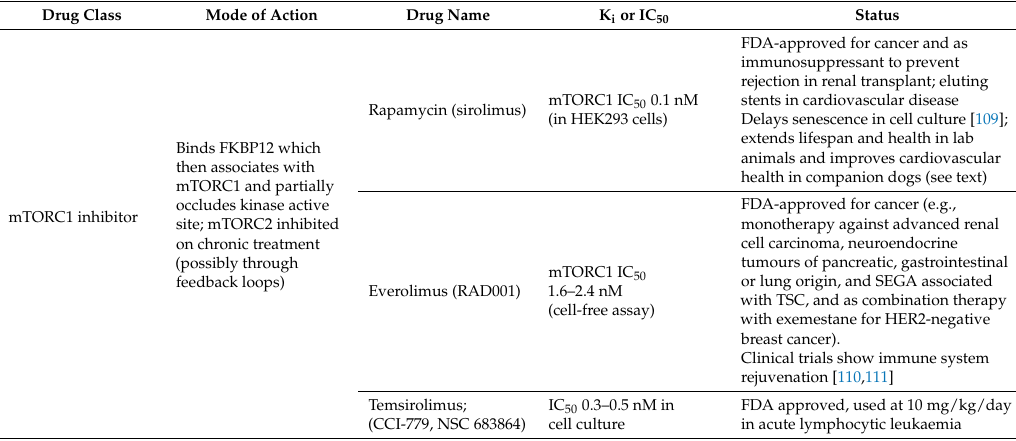
Table 3. Classes of mTOR pathway modulators with examples of each